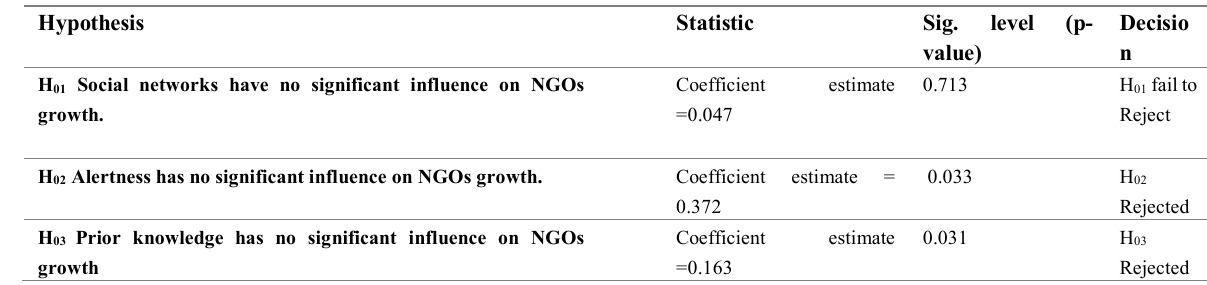
Table 5: Hypothesis testing